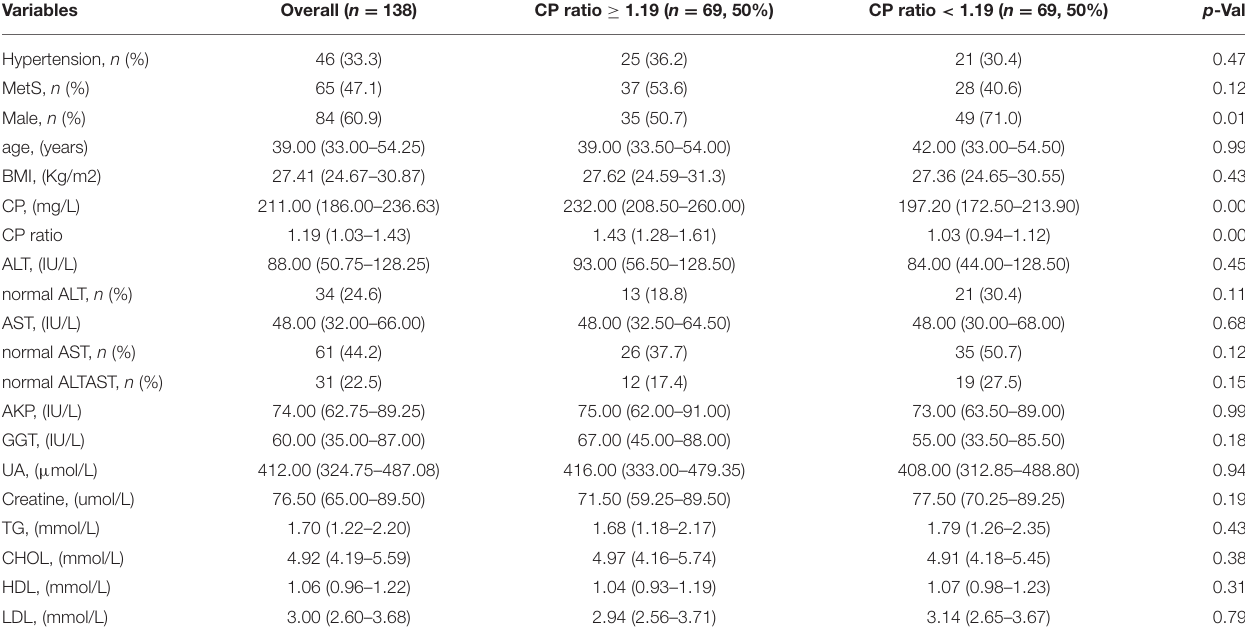
TABLE 1 | The characteristics of patients in the low and high CP ratio